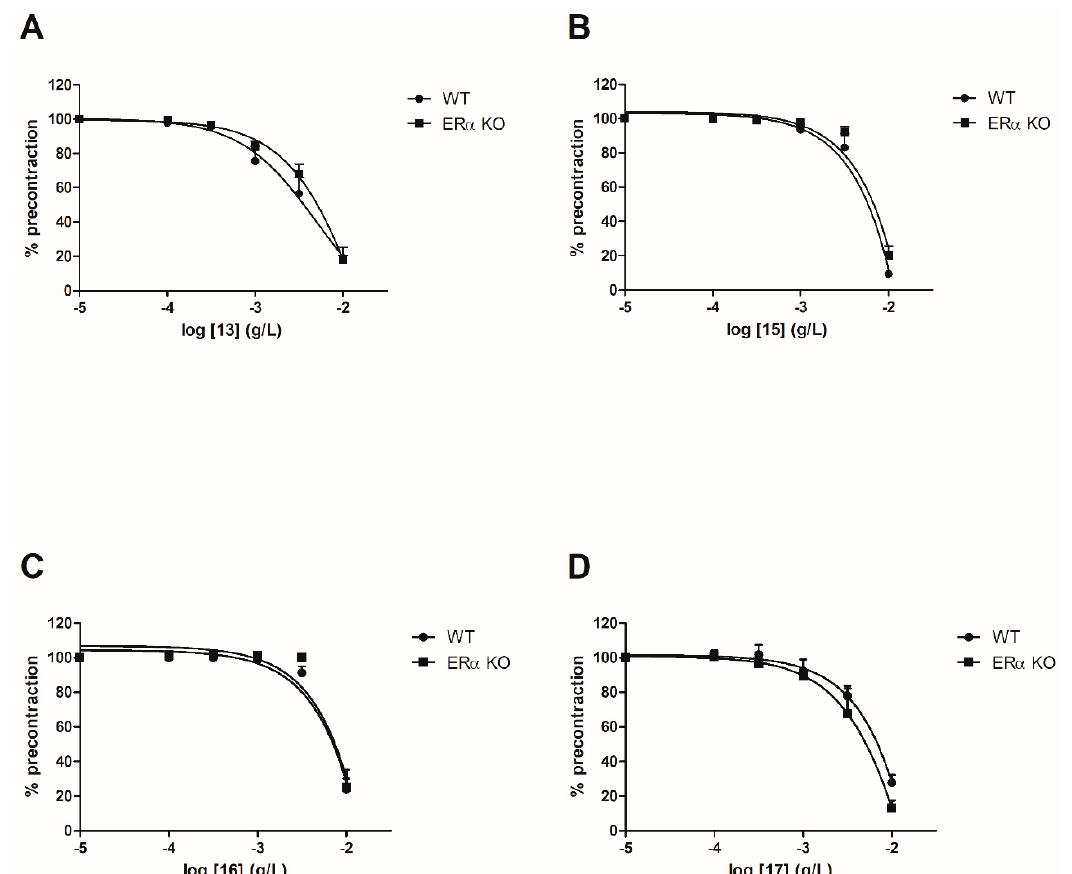
Figure 3. Concentration-response curves for the vasorelaxation e ff ect on both WT and ER α KO mice thoracic aorta of synthetic chalcones 13 ( A ), 15 ( B ), 16 ( C ) and 17 ( D ). Mice were ovariectomized 7 days before the experiment. Vessels were pre-contracted with U46619, phenylephrine, and serotonin, at 80 % of their maximal response. The presence of functional endothelium was assessed by determining the ability of acetylcholine (10 µ M) to induce more than 50% relaxation of pre-contracted rings. Results are expressed in percentage of precontraction ( y -axis) following the concentration ( x -axis). No significant di ff erences were observed with synthetic chalcones 13 , 15 , 16 and 17 . N = 4–7 (Mann-Whitney).